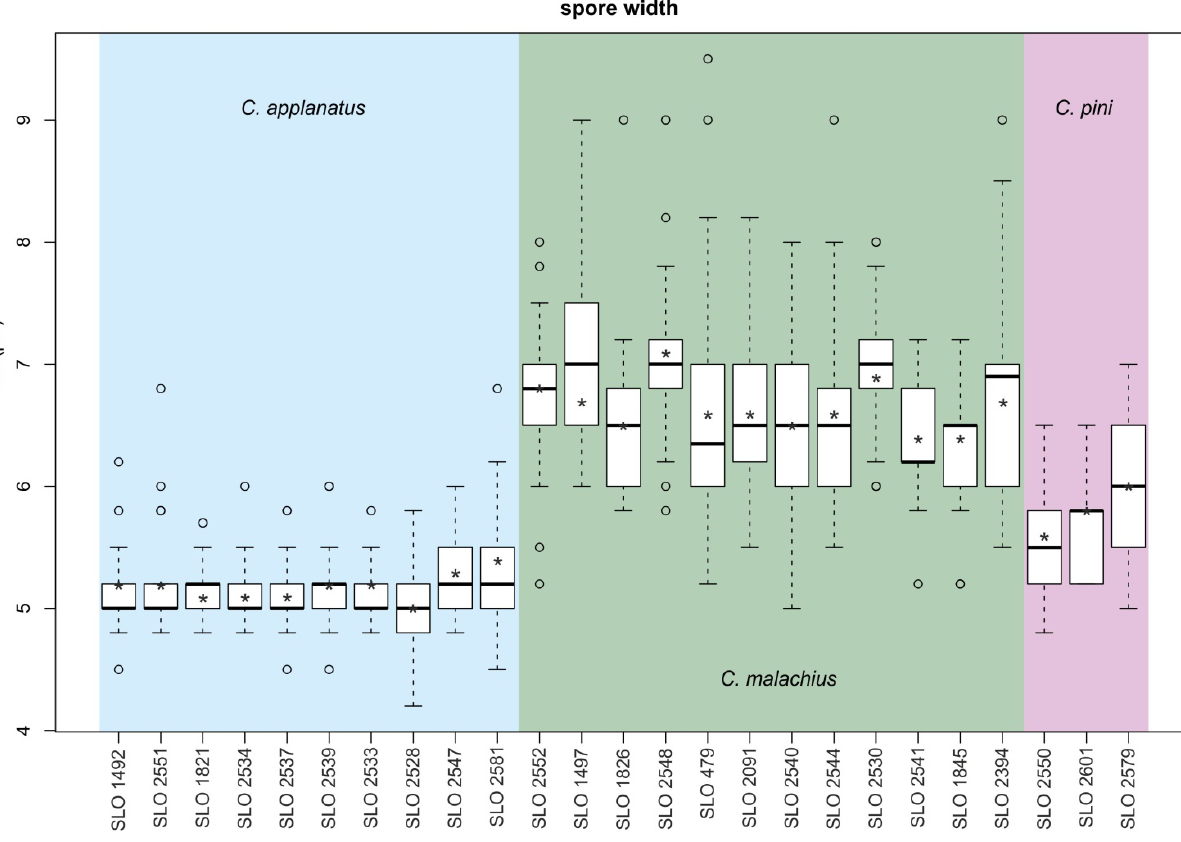
Figure 2. Boxplot charts comparing basidiospore width of three studied Crepidotus species. Asterisk represent average, thick horizontal line median and circles are outliers.